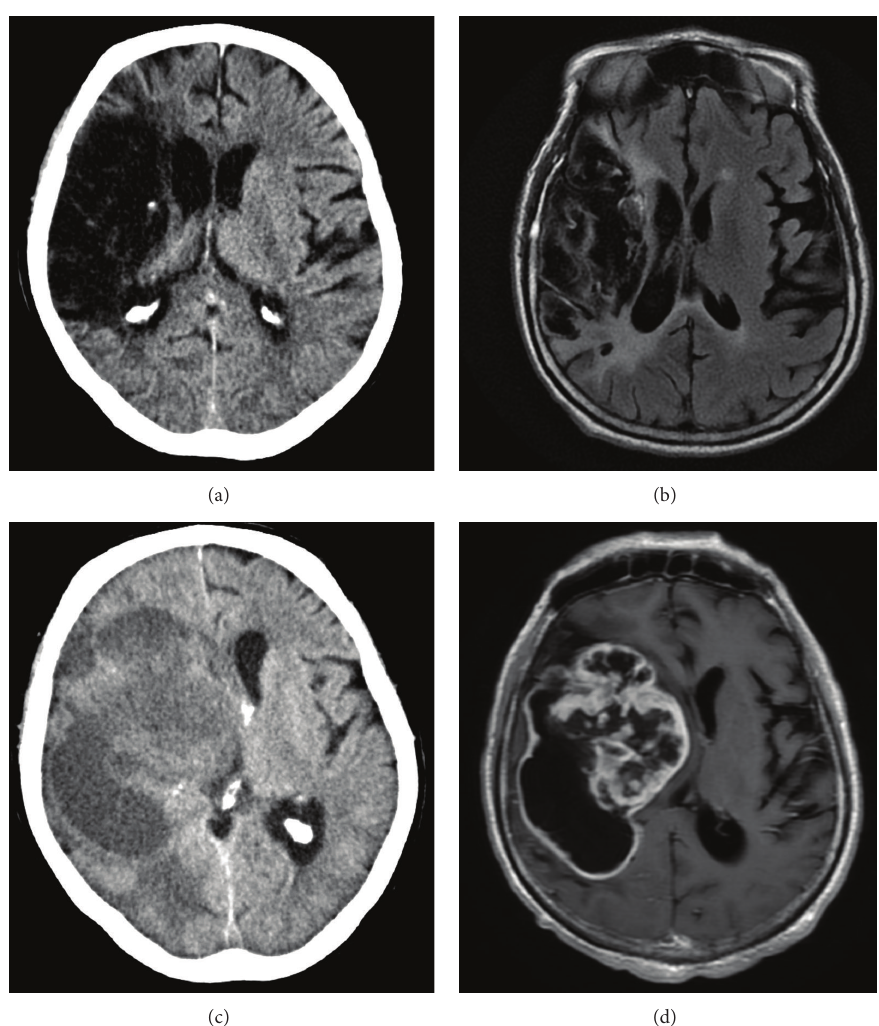
Figure 2: Evolution of gliotic scar after ischemic stroke. (a) CT without contrast 17 months after ischemic stroke, showing a gliotic scar. (b) MRI FLAIR sequence 17 months after ischemic stroke, showing gliotic scar within the previously infarcted region. (c) CT without contrast two years after ischemic stroke, showing a dense, cystic area in the right frontal, temporal, and parietal lobes, corresponding to the region of the prior infarct. (d) MRI T1 sequence after gadolinium contrast two years after ischemic stroke, showing contrast-enhancing, necrotic mass in the previously infarcted